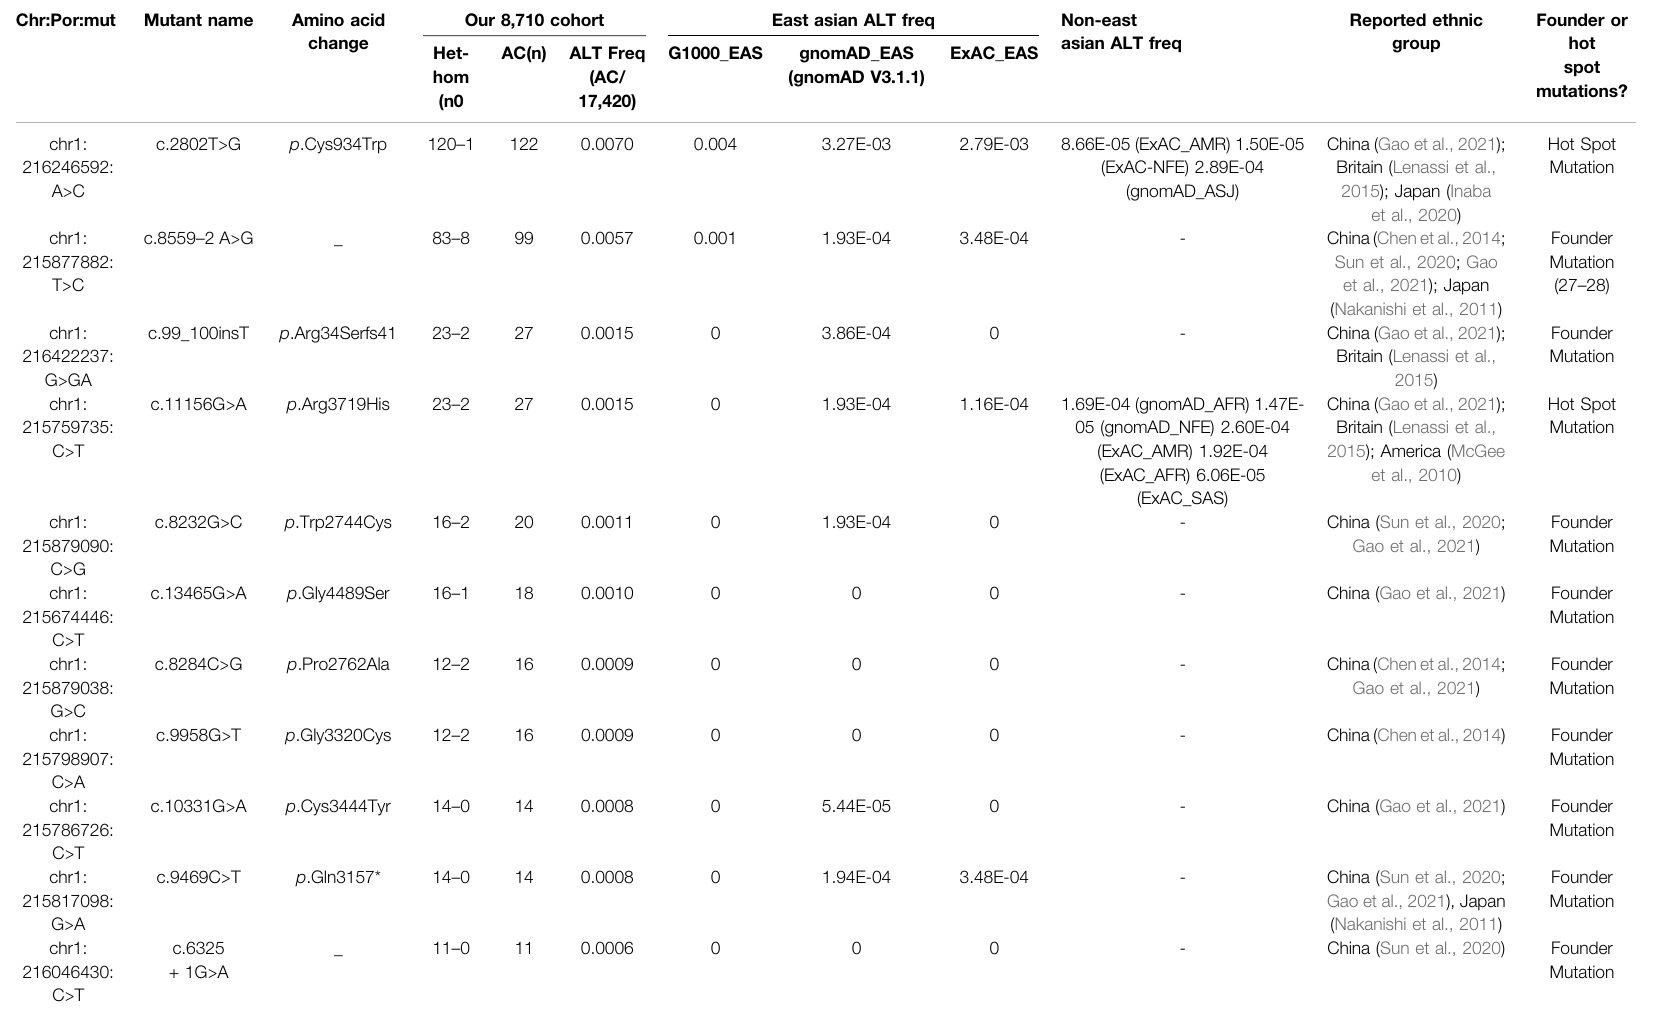
TABLE 2 | Top eleven frequent mutations with an allele count ≥